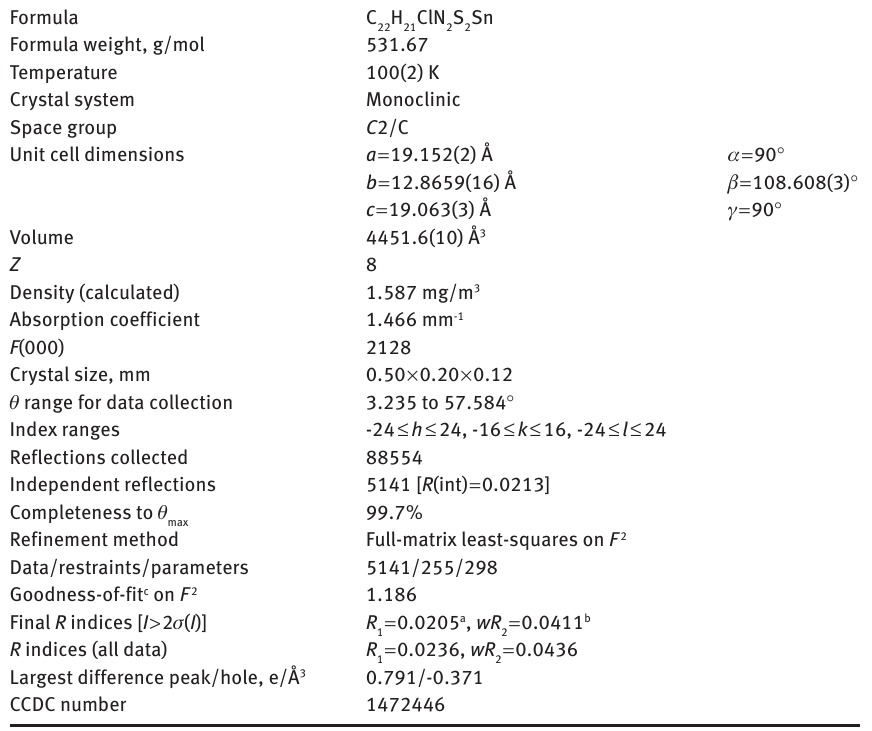
Table 1: Crystal data and structure refinement of 1 .